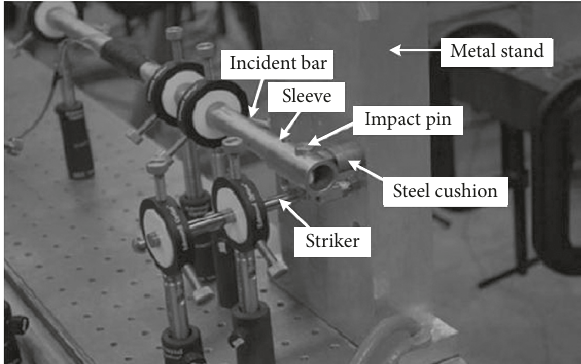
Figure 7: Direct impact loading TSHB designed by Nie et al.